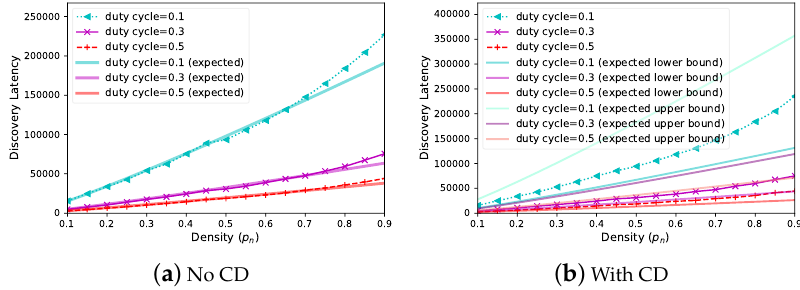
Figure 9. Discovery latency increases when the network becomes